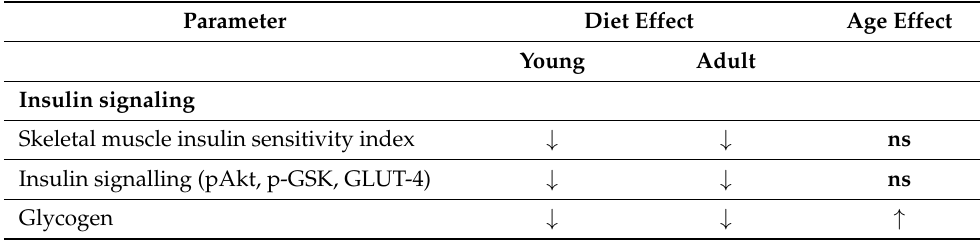
Table 2. Summary of